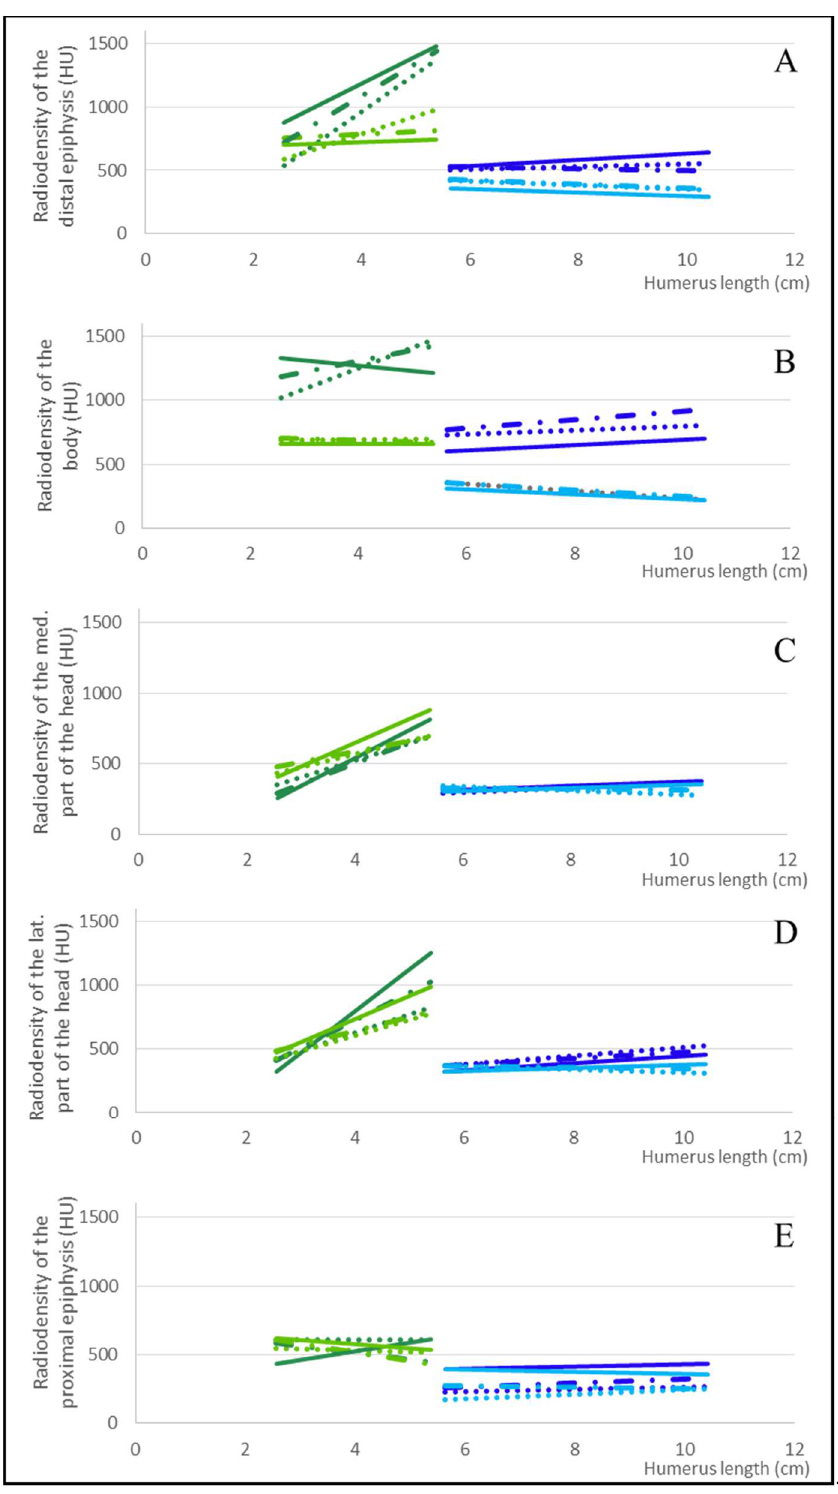
Figure 4. The graphs compare the radiodensity regression lines between the Atlantic spotted dolphin and the pygmy sperm whale at the ( A ) distal epiphysis of the humerus, ( B ) humeral body, ( C ) medial aspect of the humeral head, ( D ) lateral aspect of the humeral head, and ( E ) proximal epiphysis. The regression lines of the cortical bone of the Atlantic spotted dolphin are dark green in colour, and the regression lines of the trabecular one of the same species are light green. On the other hand, the regression lines of the cortical bone of the pygmy sperm whale are dark blue, and the regression lines of the trabecular bone of the same species are light blue.